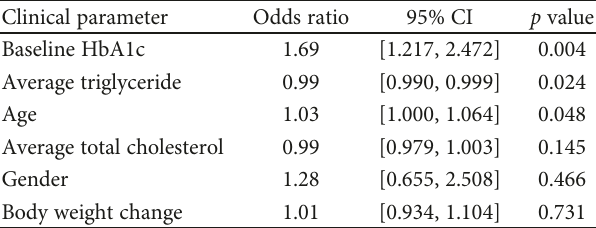
Table 2: Multiple logistic regression analysis of factors related with e ffi cacy of DPP-4 inhibitor in all participants with type 2